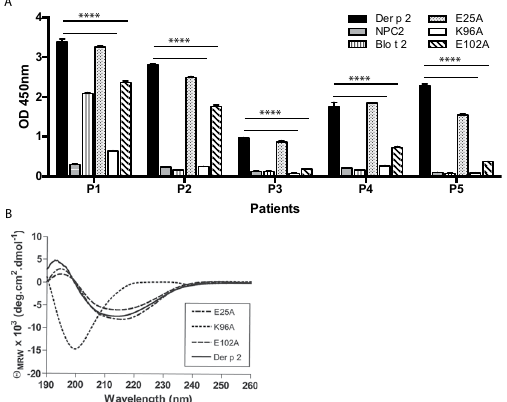
Figure 1. ( a ) Amount of IgE binding of 5 allergic individuals to Der p 2, hNPC2, Blo t 2 and selected site directed mutants of Der p 2. Mean and standard deviations of two independent assays performed in triplicates are presented. Differences between individual serum IgE binding to Der p 2 and mutants K96A and E102A were statistically significant (p < 0.0001). ( b ) Far UV circular dichroism spectra of wild type Der p 2, and mutants E25A, K96A, and E102A. Average spectra from 10 scans are